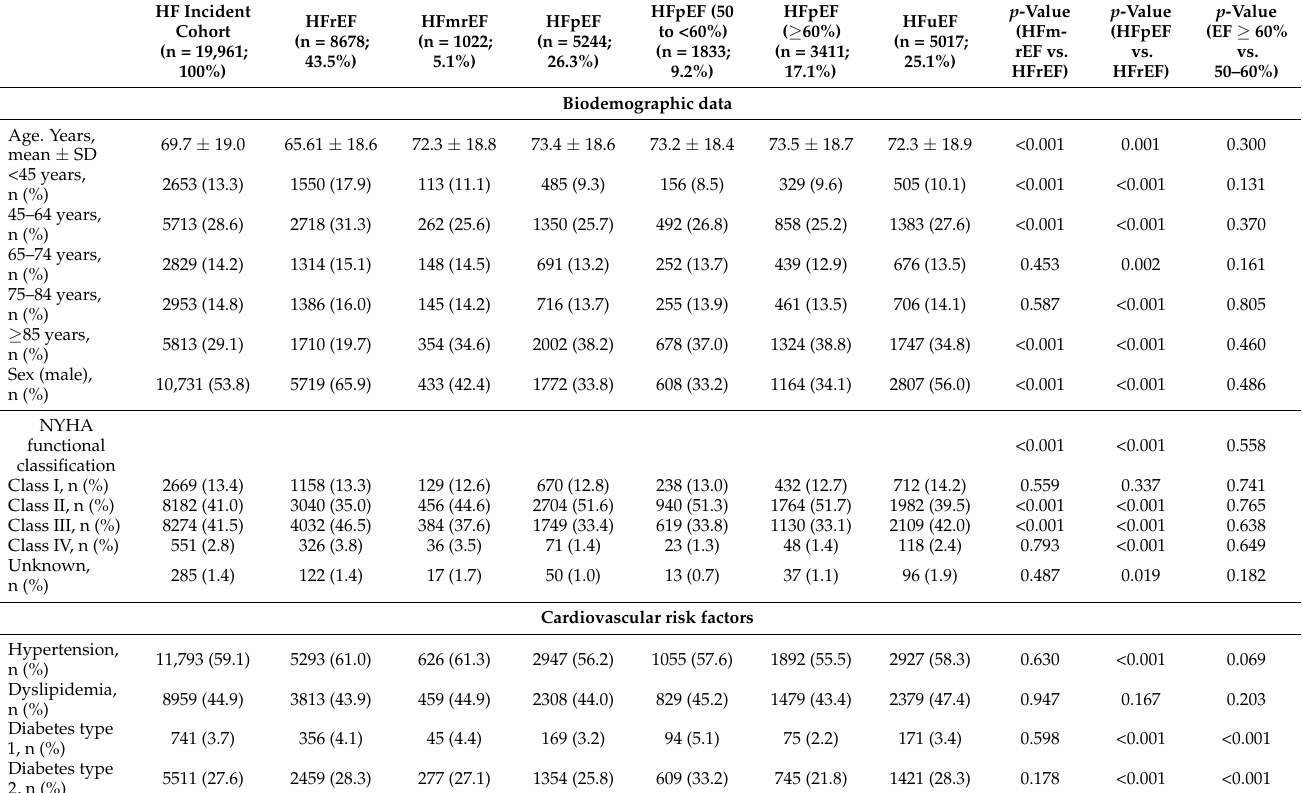
Table 1. Baseline clinical characteristics and treatments in the incident HF cohort (index date